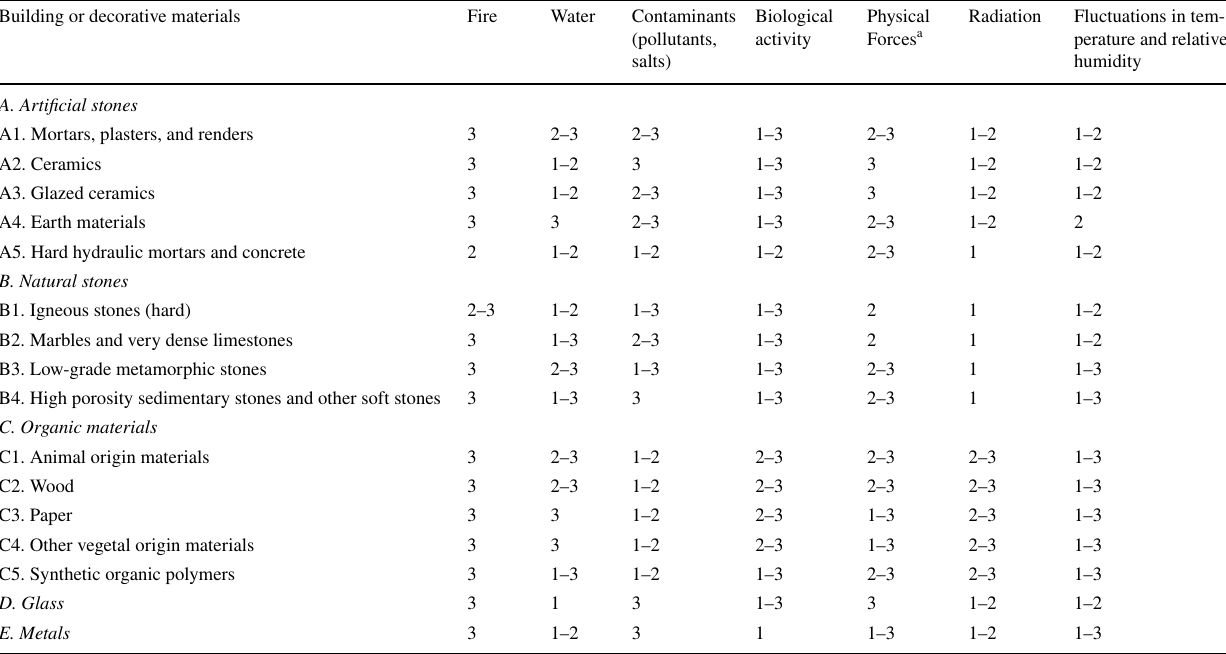
Table 2 An indicative sensitivity ranking matrix of heritage materials to environmental threats